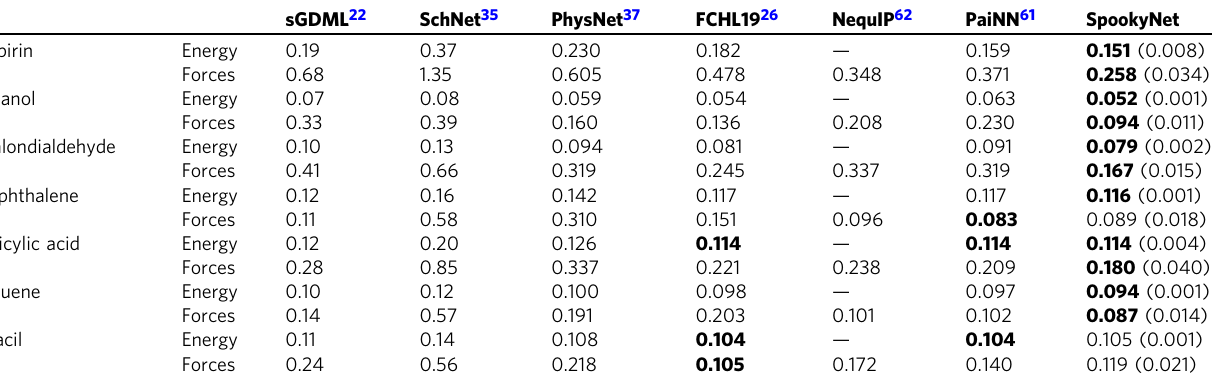
sGDML 22 SchNet 35 PhysNet 37 FCHL19 26 NequIP 62 PaiNN 61 SpookyNet